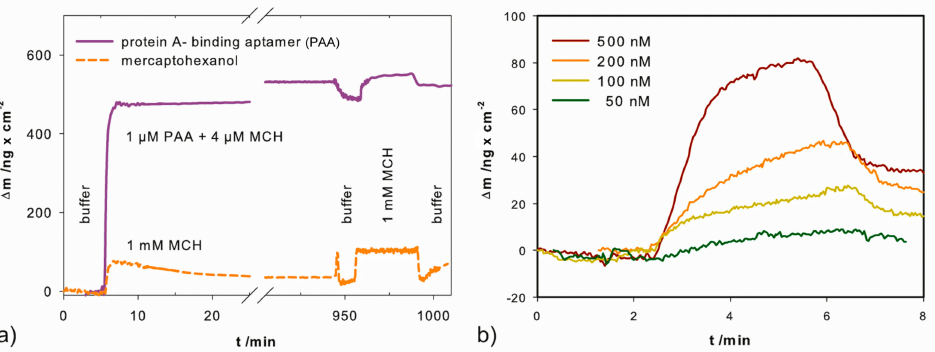
Figure 3. Quartz crystal microbalance measurements: ( a ) mass change ∆ m versus time of gold covered quartz crystals incubated with aptamer/6-mercapto-1-hexanol (MCH) (violet solid line) or MCH (orange dashed line) and subsequently blocked with 1 mM MCH; ( b ) ∆ m versus time of an aptamer-modified crystal incubated with different concentrations of protein